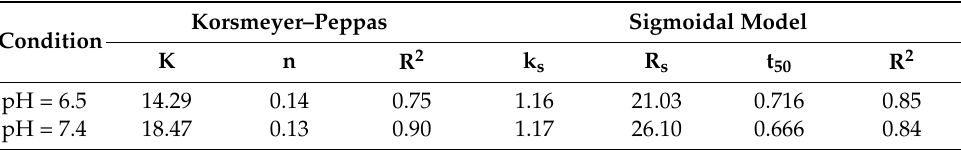
Table 6. Correlation coefficient (R 2 ) of the release mechanism model Sigmoidal and Korsmeyer–Peppas according to various